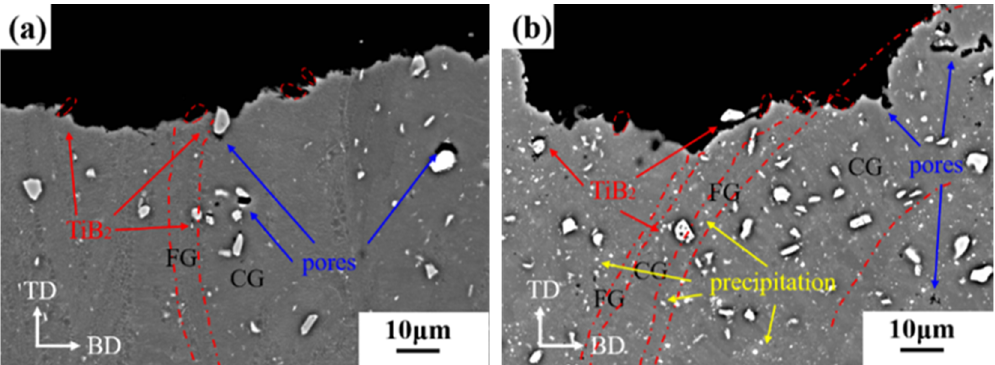
Figure 15. Fracture side surfaces of SLM-fabricated TiB 2 /AlZnMgCu(Sc,Zr) composite vertical plane in relatively high magnification: ( a ) as-printed sample and ( b ) heat-treated sample.